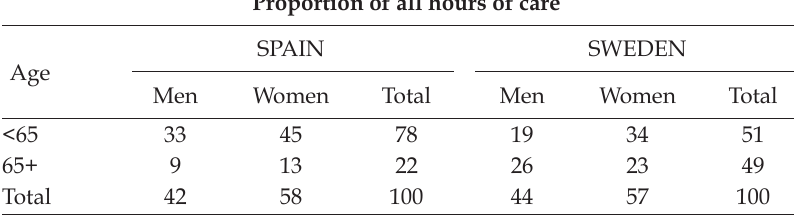
Table 4. Proportion of all hours of caregiving, and proportion of all care- givers, by gender and age group, Spain and Sweden, 2014 Per cent Proportion of all hours of care